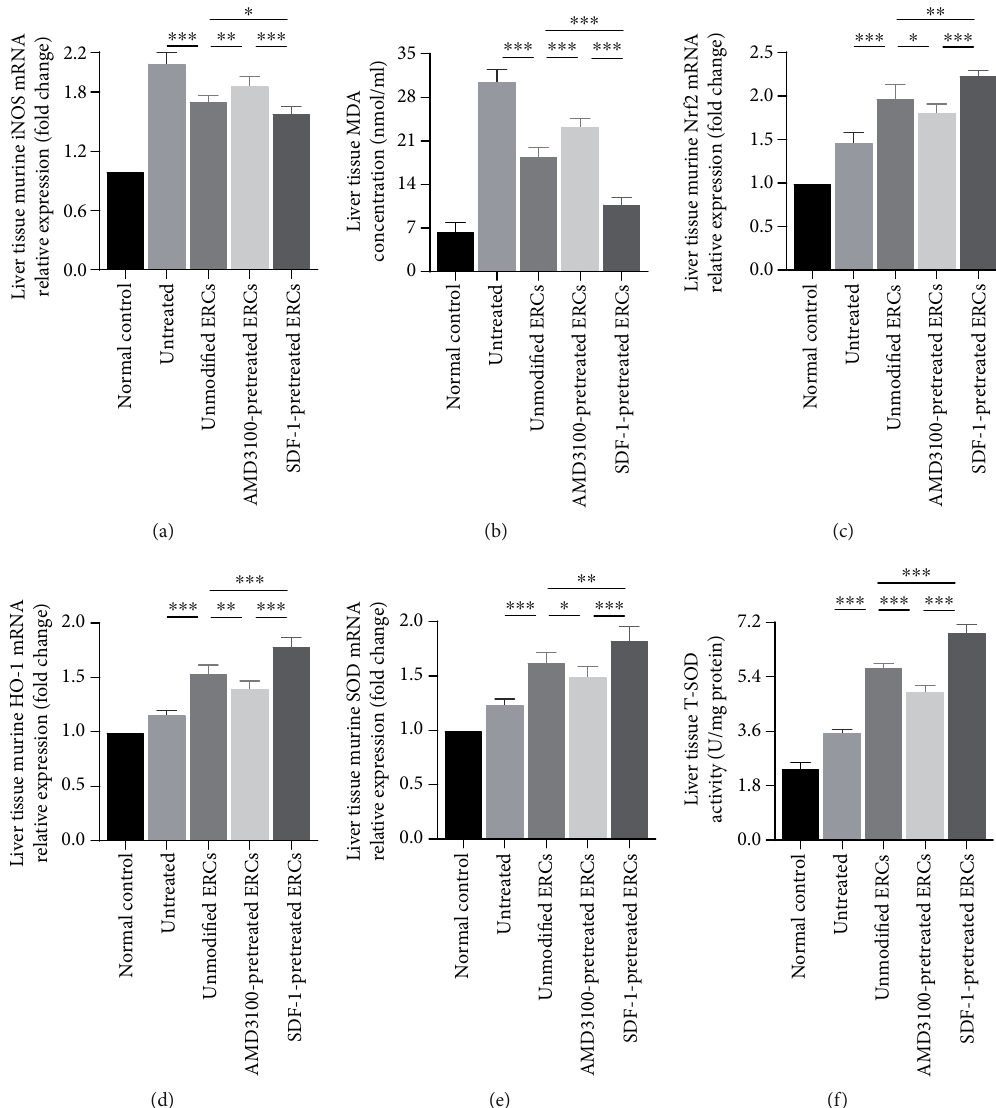
Figure 6: Pretreatment with SDF-1 further enhanced the antioxidative e ff ect of ERCs in the process of sepsis. The mRNA expression levels of murine iNOS (a), Nrf2 (c), HO-1 (d), SOD (e), T-SOD activity (f), and MDA concentration (b) in liver. Statistical analysis was performed by one-way ANOVA followed by the LSD test, n = 6 . ∗ p < 0 : 05 , ∗∗ p < 0 : 01 , and ∗∗∗ p < 0 : 001 . Bar graphs represent mean ± SD . Abbreviation: ERCs: endometrial regenerative